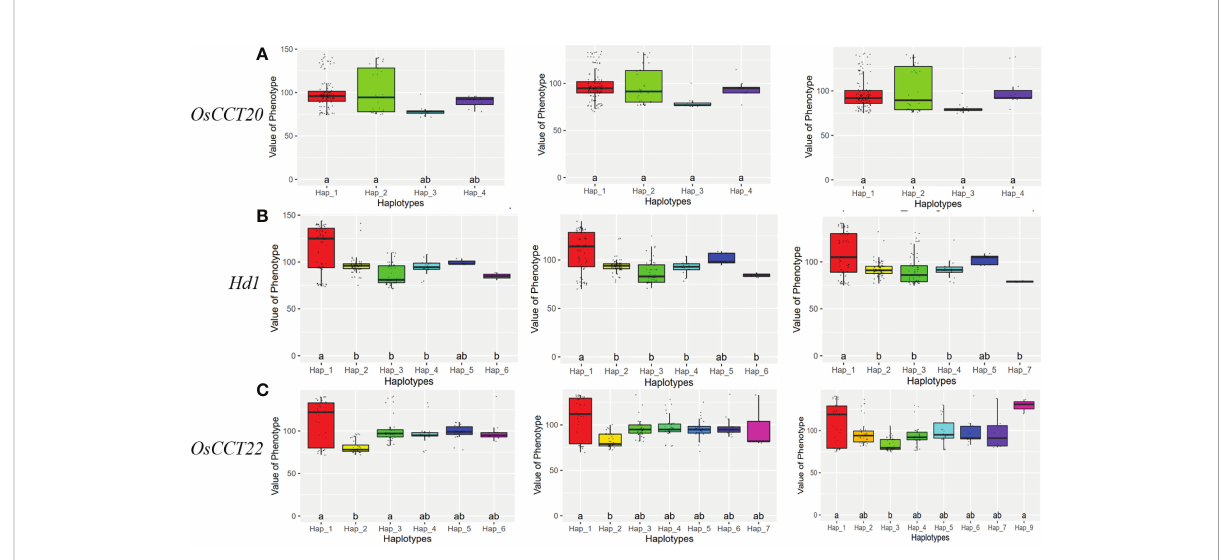
FIGURE 3 Boxplots of the heading date phenotype for different haplotypes of candidate genes. (A) A 3-year heading date box for the different haplotypes of OsCCT20 . (B) A 3-year heading date box for the different haplotypes of Hd1 . (C) A 3-year heading date box for the different haplotypes of OsCCT22. Duncan ’ s test at p ranks the phenotypic differences. The letter a and b are ranked by Duncan ’ s test at